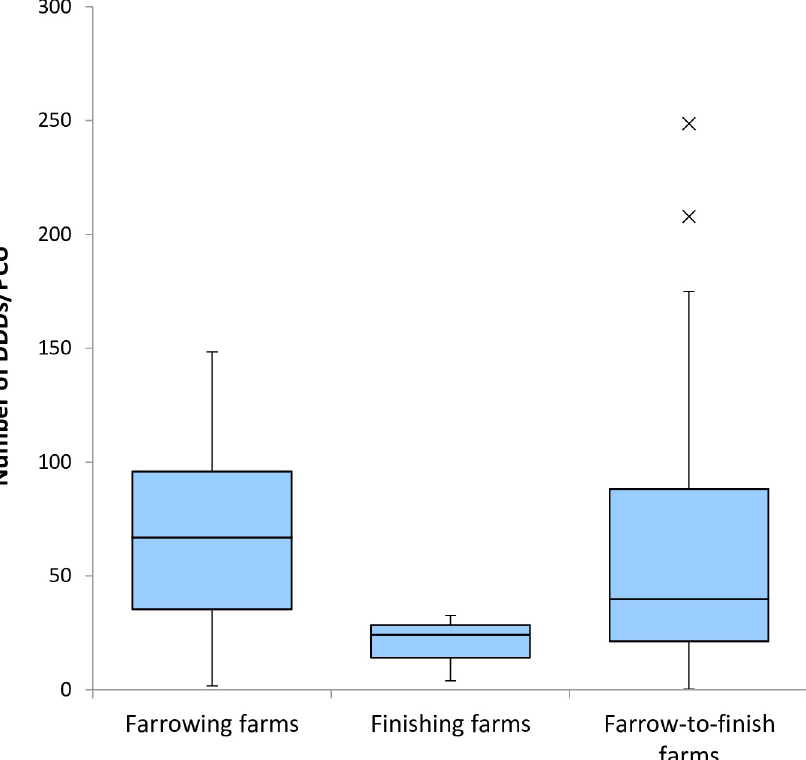
Fig 5. Box-and-whisker plot of antimicrobial use in the number of defined daily doses (DDDjp) per kg of PCU (population correction unit) on different types of farms (farrowing, finishing and farrow-to-finish farms) in 2019. The dots represent the range out of ± 1.5 × interquartile range (IQR). No significant difference was observed between any types of farms as a result of Kruskul-Wallis test ( P =